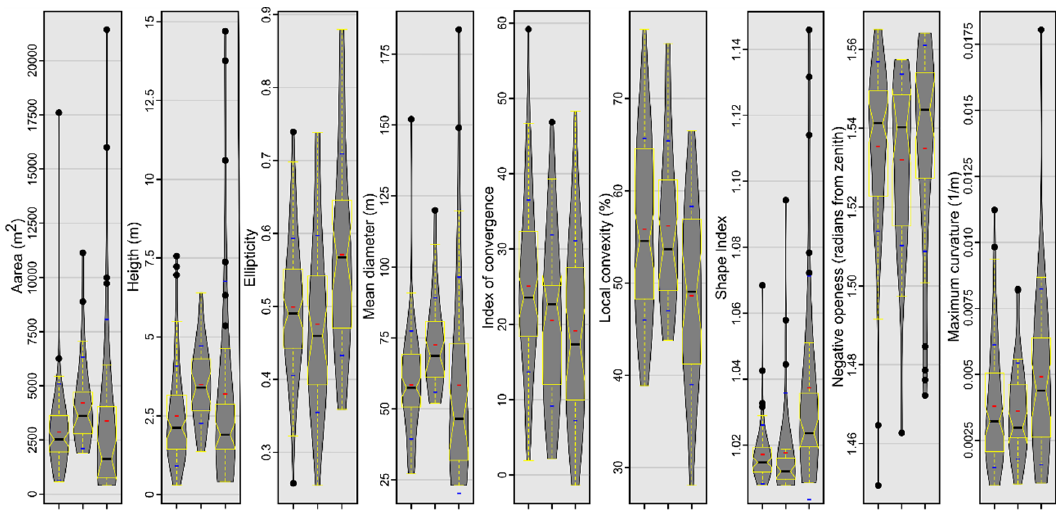
Figure 7. The descriptive statistics of burial mounds geomorphometry (black dots—outliers, black horizontal line—median, red horizontal line—mean, blue horizontal line—± standard deviation, grey polygon—kernel density, yellow boxplot with notch—interquartile range representing 50% of the data, upper part representing the 75th percentile, while the lower part the 25th percentile, lower whisker—minimum, upper whisker—maximum, notch—95% confidence interval of the median), for the fitting area (left, n = 68), for the testing area (center, n = 29) and other mound types geomorphometry (right, n = 33, for both the northern and the southern study areas). (a high-resolution version can be found at https: // doi.org / 10.6084 /